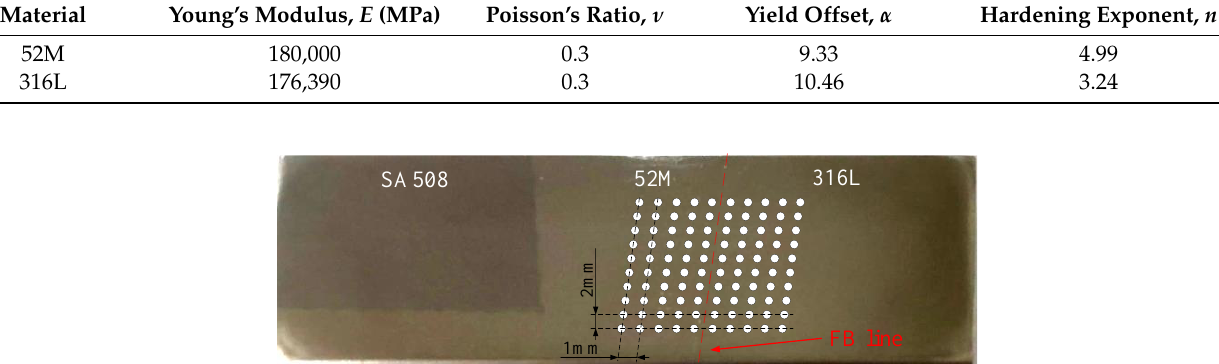
Figure 3. Vickers hardness test samples and hardness test points. 52M 316L Figure 5. Weibull statistical distribution density function curve of yield strength. With the results of the above analysis, this paper implements the definition of non- homogeneity of welded joint materials on the ABAQUS platform (ABAQUS V6.14, 2015, Dassault Systèmes, Vélizy-Villacoublay, France) through two stages: first, random sam- ples of yield strength satisfying the Weibull distribution are generated for each of the two materials. Second, the random sample data are mapped into the finite element model. The mapping approach taken in this paper is a one-to-one assignment of data to cells, which means that each cell corresponds to random data and is isotropic and homogeneous within each cell. These two steps achieve an inhomogeneous material conforming to the Weibull distribution.